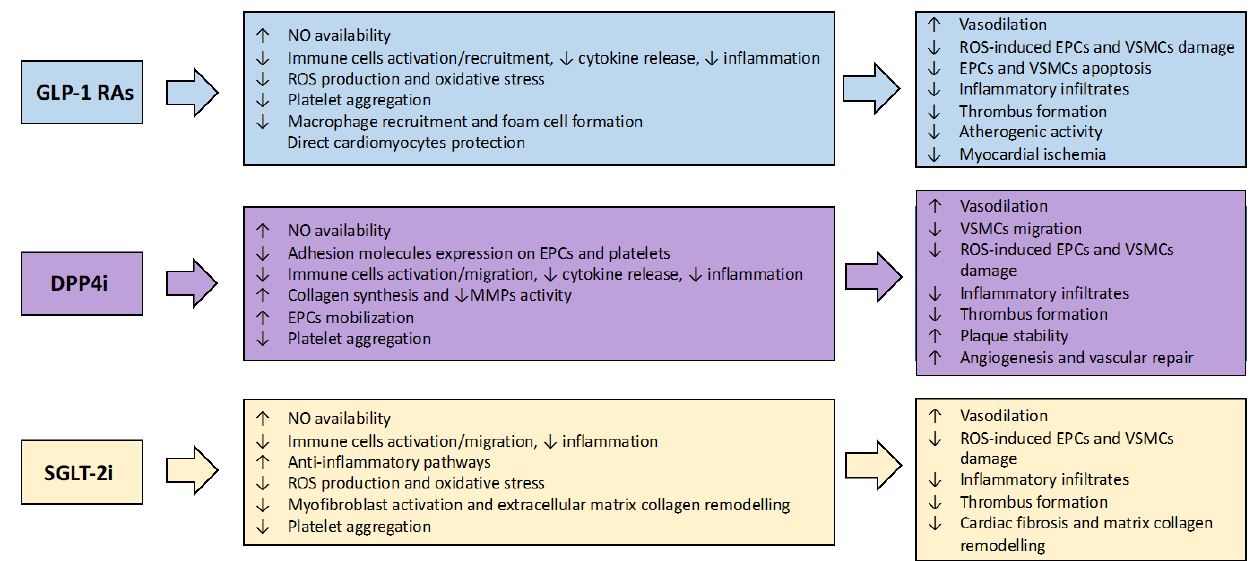
Figure 3. Potential mechanisms of benefit of novel antidiabetic agents in the setting of PCI. PCI, percutaneous coronary intervention; GLP-1 RAs, glucagon-like peptide 1 receptor agonist; DPP4i, dipeptidyl peptidase-4 inhibitors; SGLT-2i, sodium-glucose cotransporter-2 inhibitors; NO, nitric oxide; ROS, reactive oxygen species; EPCs, endothelial progenitor cells; MMPs, matrix metalloprotease; VSMCs, vascular smooth muscular cell.